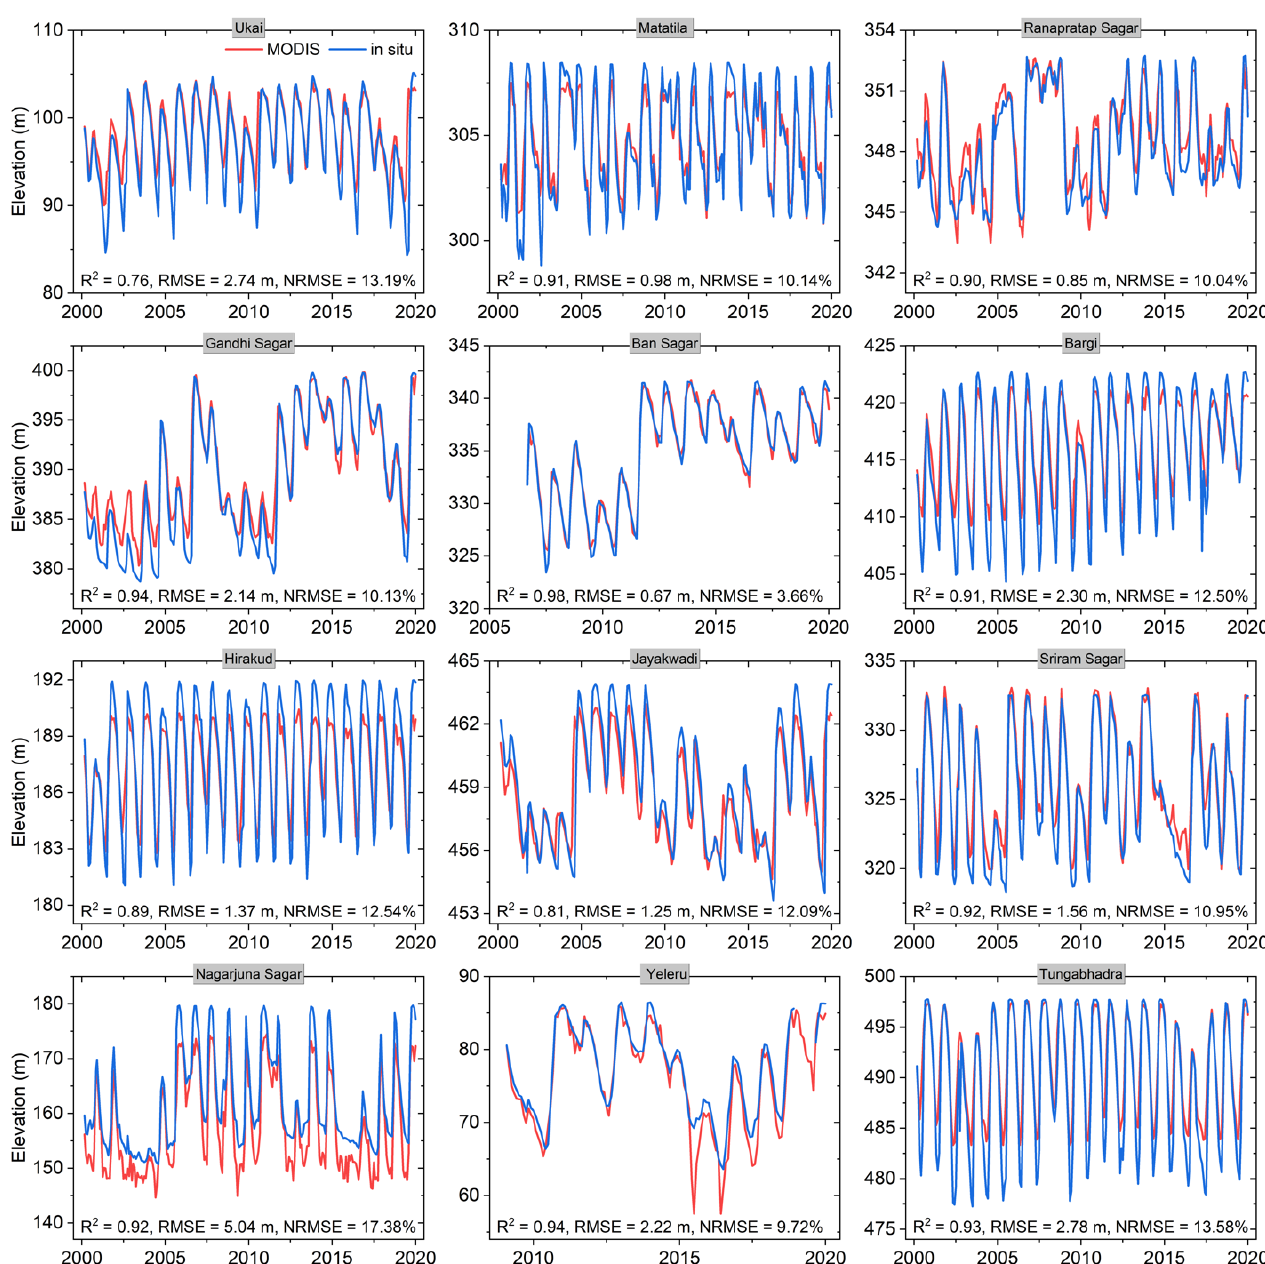
Figure A1. Validation of monthly elevation products for twelve Indian reservoirs from 2000 to 2019.